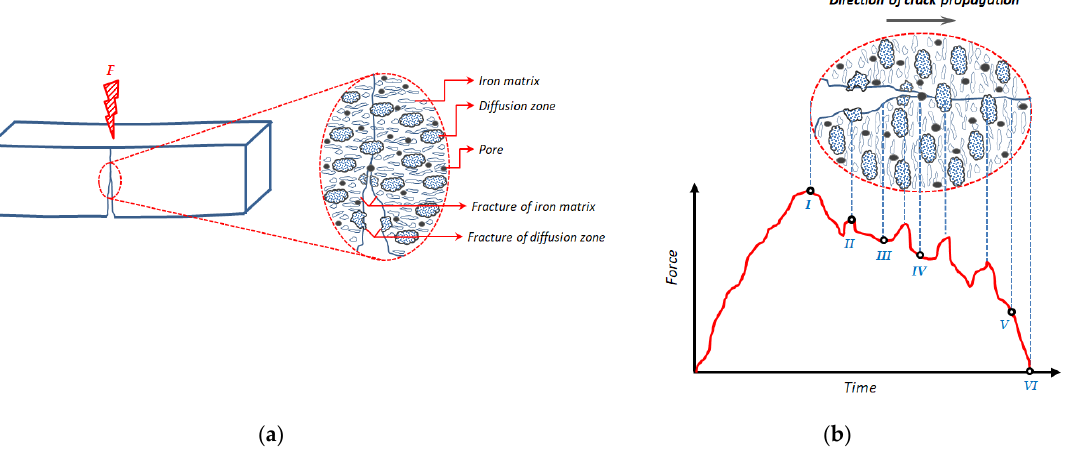
Figure 13. Representation of: ( a ) the propagation of cracks throughout the cross-section of the composite specimen; ( b ) the effect of the microstructure on the contact force−time curve.